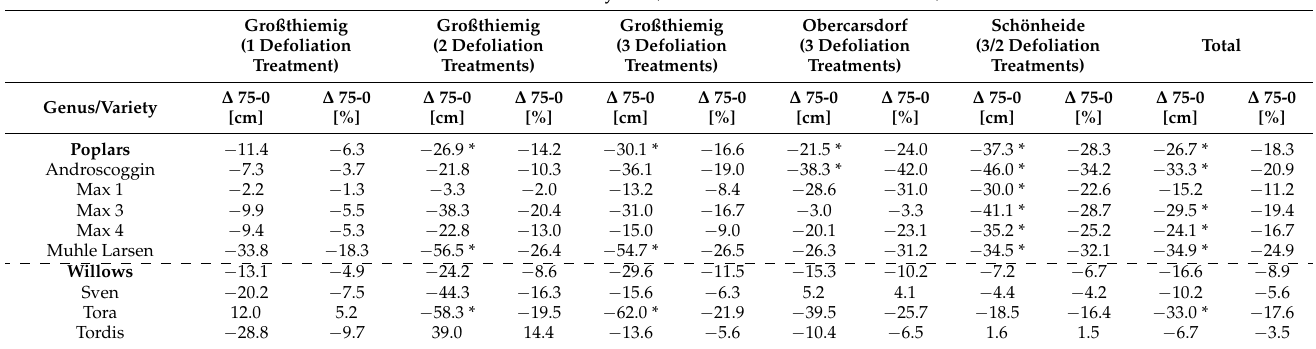
Table 4. Height differences between 75% defoliated and undefoliated plants ( ∆ 75-0) prior to the start of the growing season in 2009 after a one-time, two-time, or three-time defoliation treatment (* statistically significant difference according to t or Welch